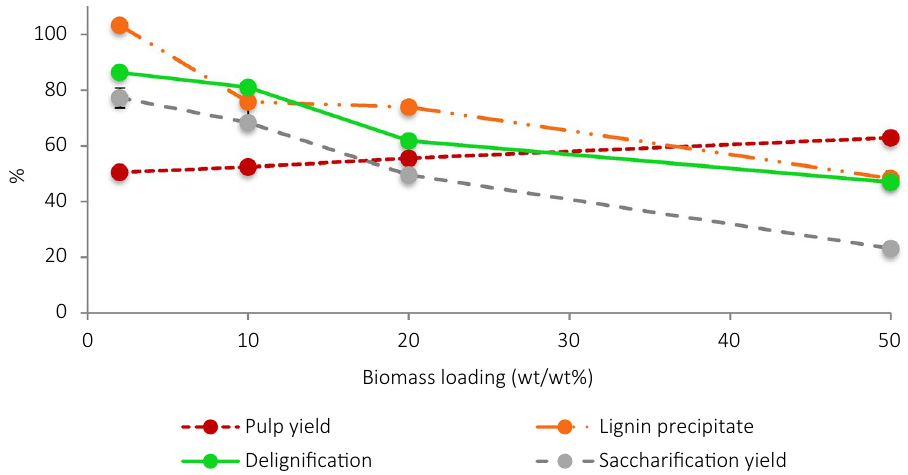
Figure 1. Comparison of the key pretreatment parameters—pulp yield, lignin and saccharification yields and delignification- after pretreatment of Miscanthus with [TEA][HSO 4 ] (water content of 20 wt%) for 6 h at 120 °C at different biomass loadings, ranging from 2 to 50 wt%. Errors were calculated as standard deviation across triplicates.